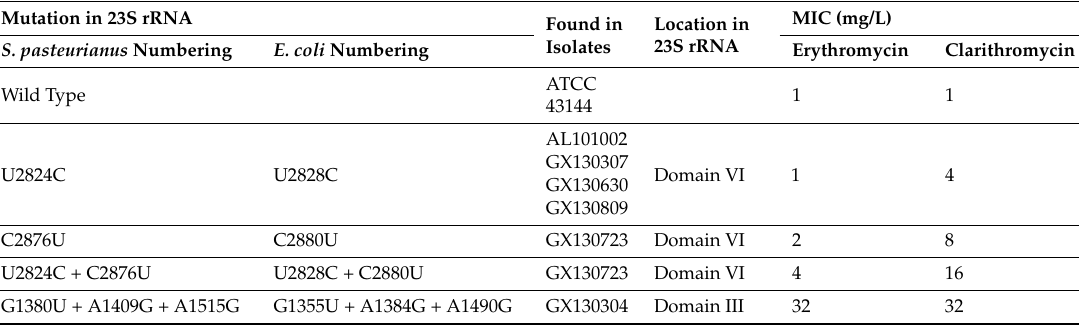
Table 2. MICs of macrolides contributed by nucleotide substitutions in 23S rRNA. Mutation in 23S